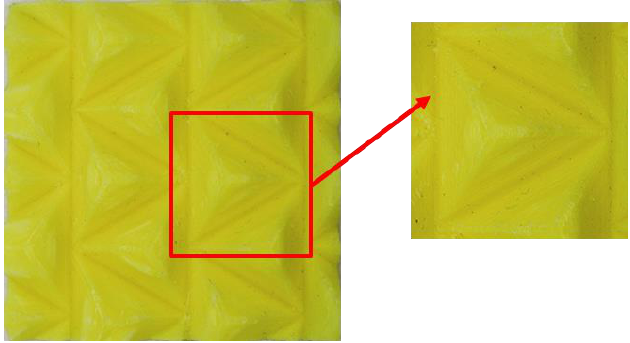
Figure 12. The panel plastic deformation.